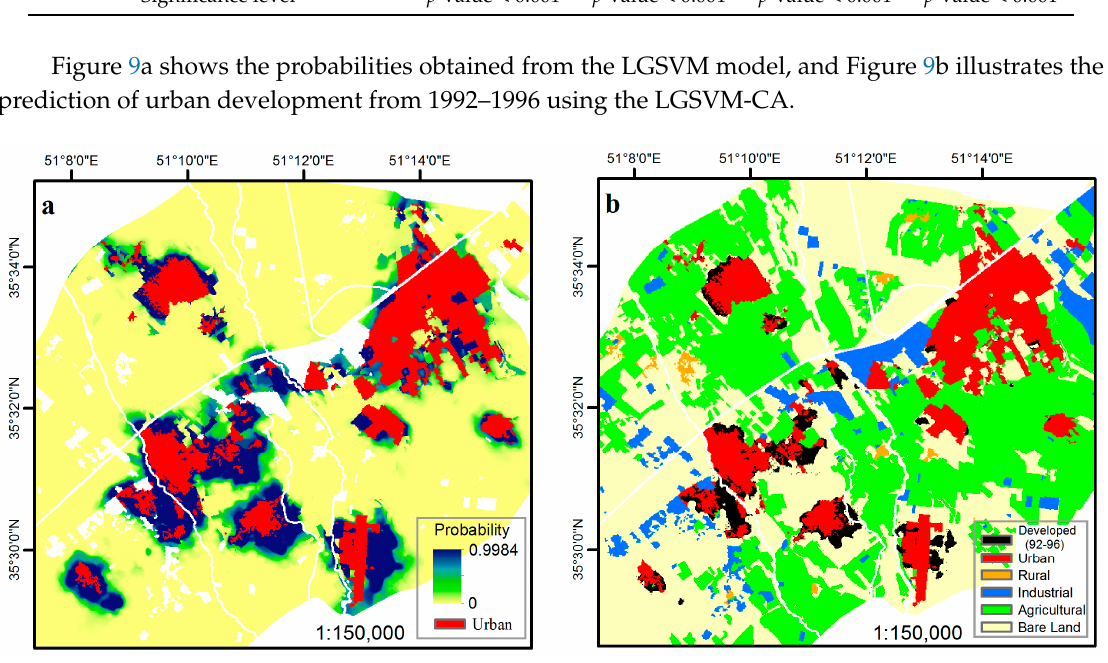
Figure 9. ( a ) LGSVM probability map and ( b ) urban growth prediction simulated by the LGSVM-CA.